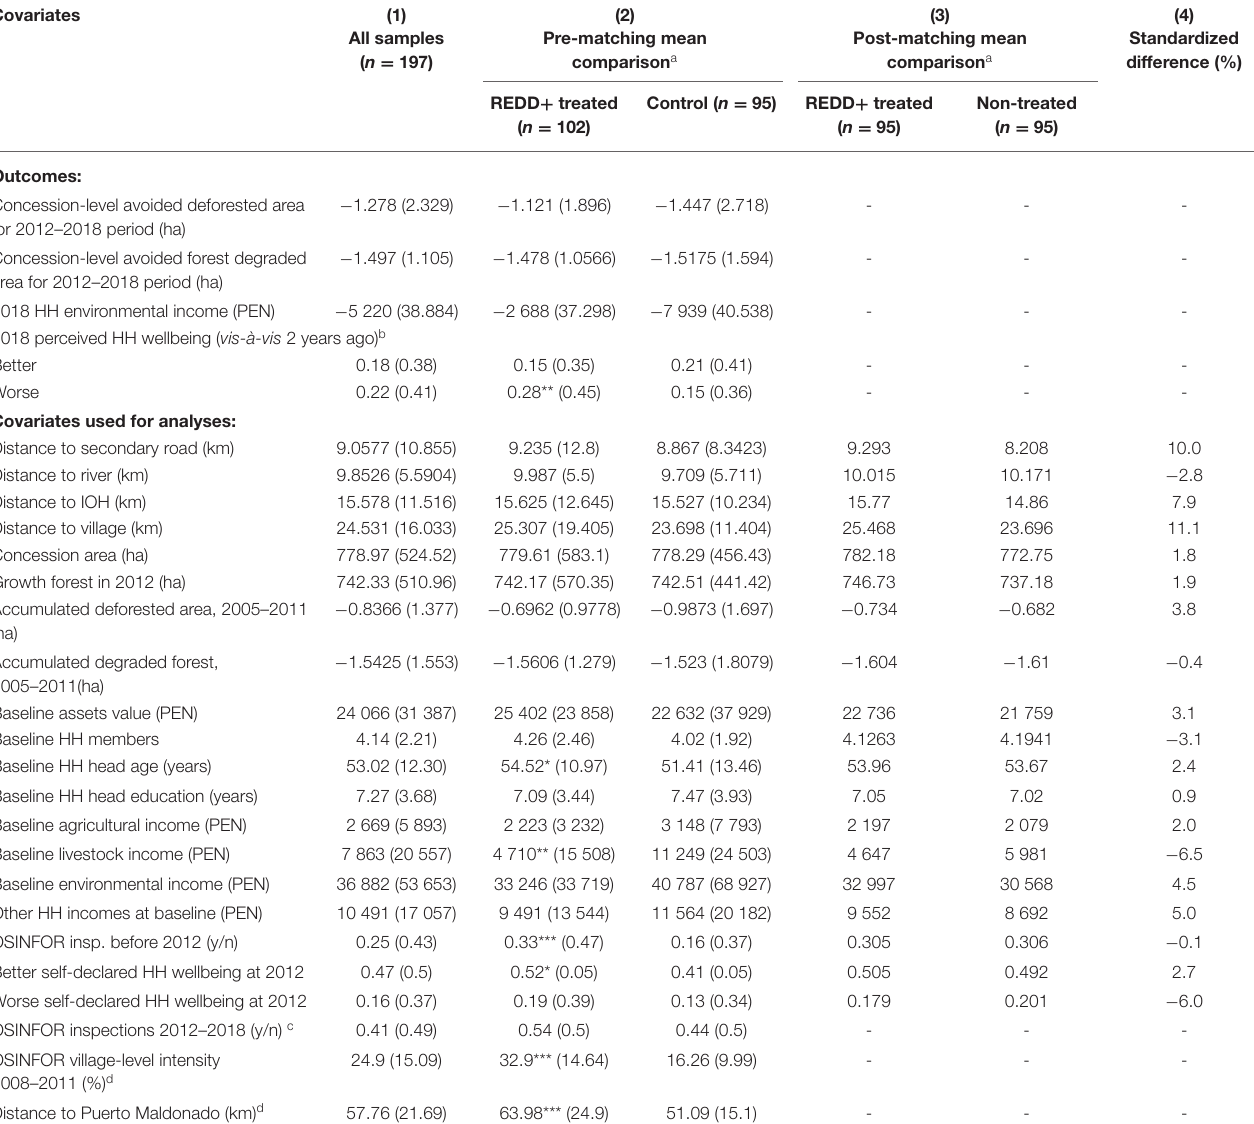
TABLE 2 | Summary statistics before and after matching.